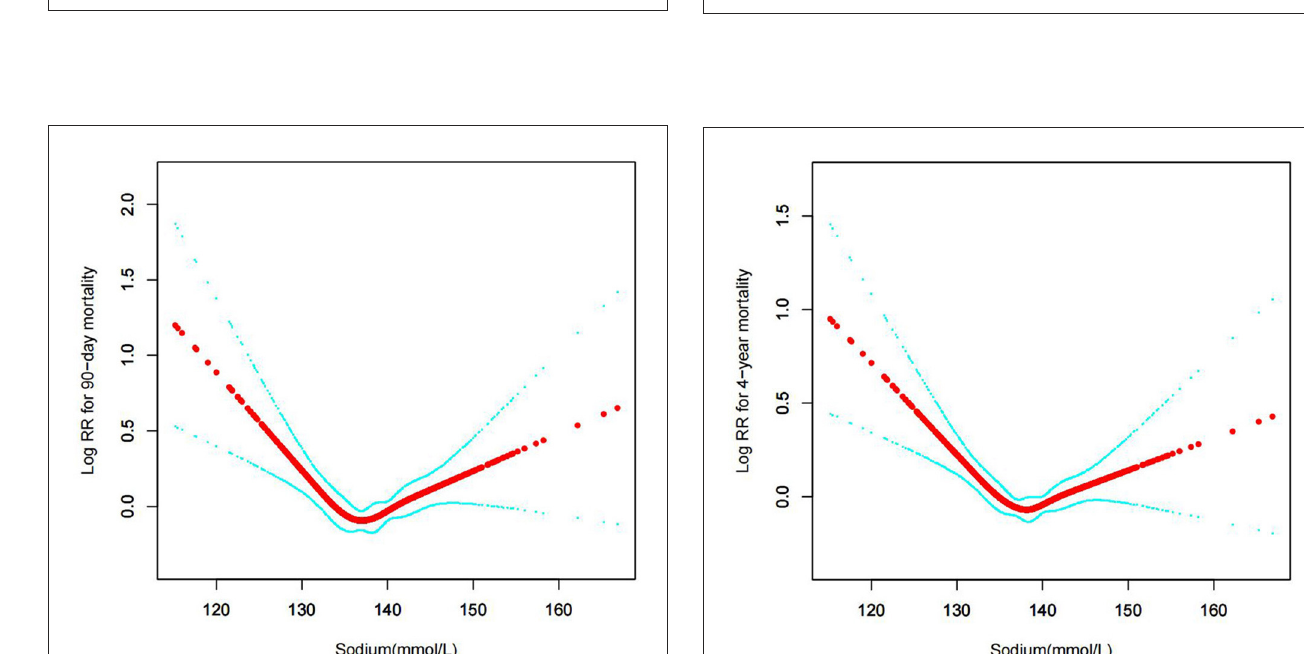
FIGURE9 Association between serum sodium levels and 365-day all-cause mortality (After adjustment for other covariates). A generalized additive model (GAM) revealed a threshold, non-linear relationship between serum sodium levels and 365-day all-cause death. U-shaped relationships were observed after adjustment for other covariates by spline smoothing plot. The smooth curve fit between variables is shown by a solid rad line. The 95% confidence interval from the fit is represented by imaginary blue lines.